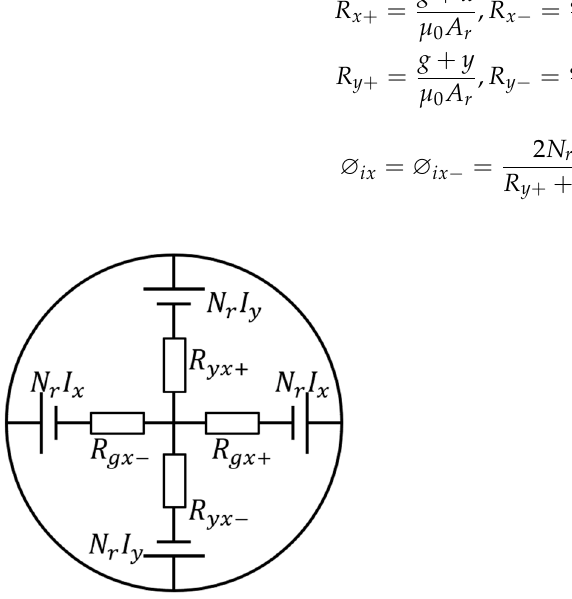
Figure 2. Conventional model magnetic equivalent circuit.